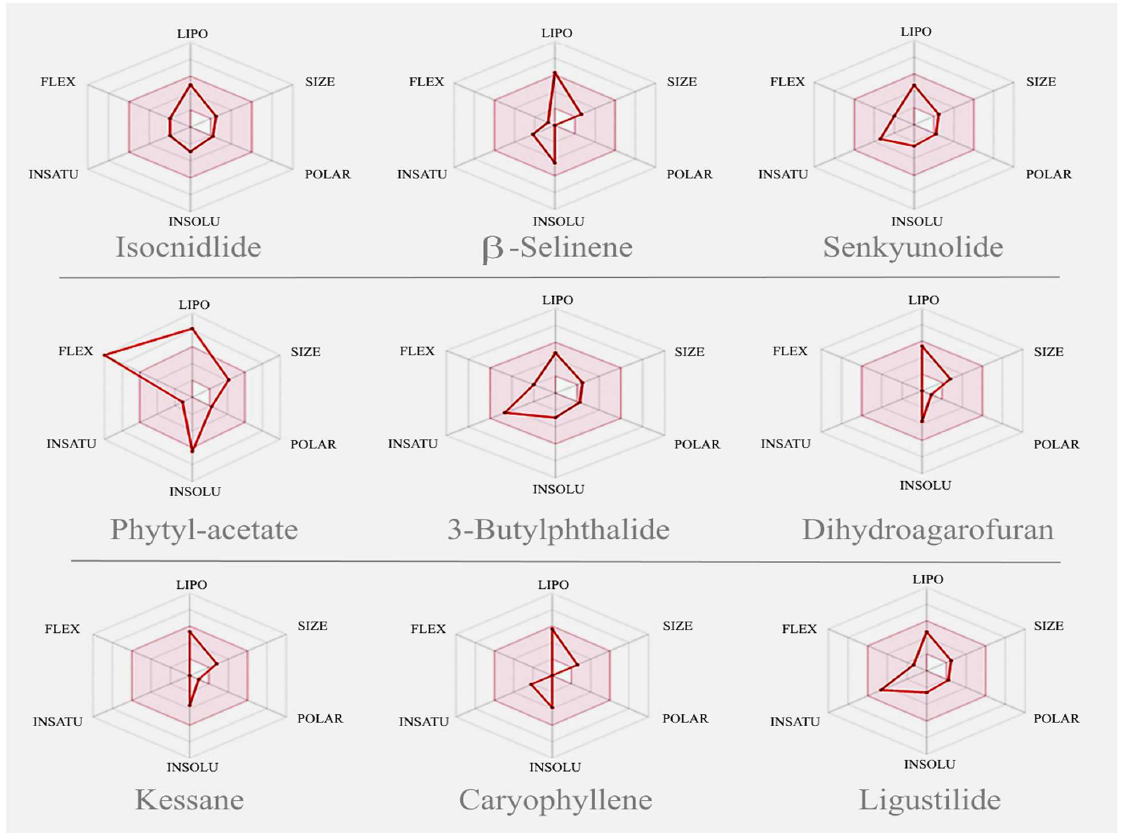
Figure 5. Bioavailability radar graph of nine compounds of AGO (pink area showed the drug likeness properties of the molecule).